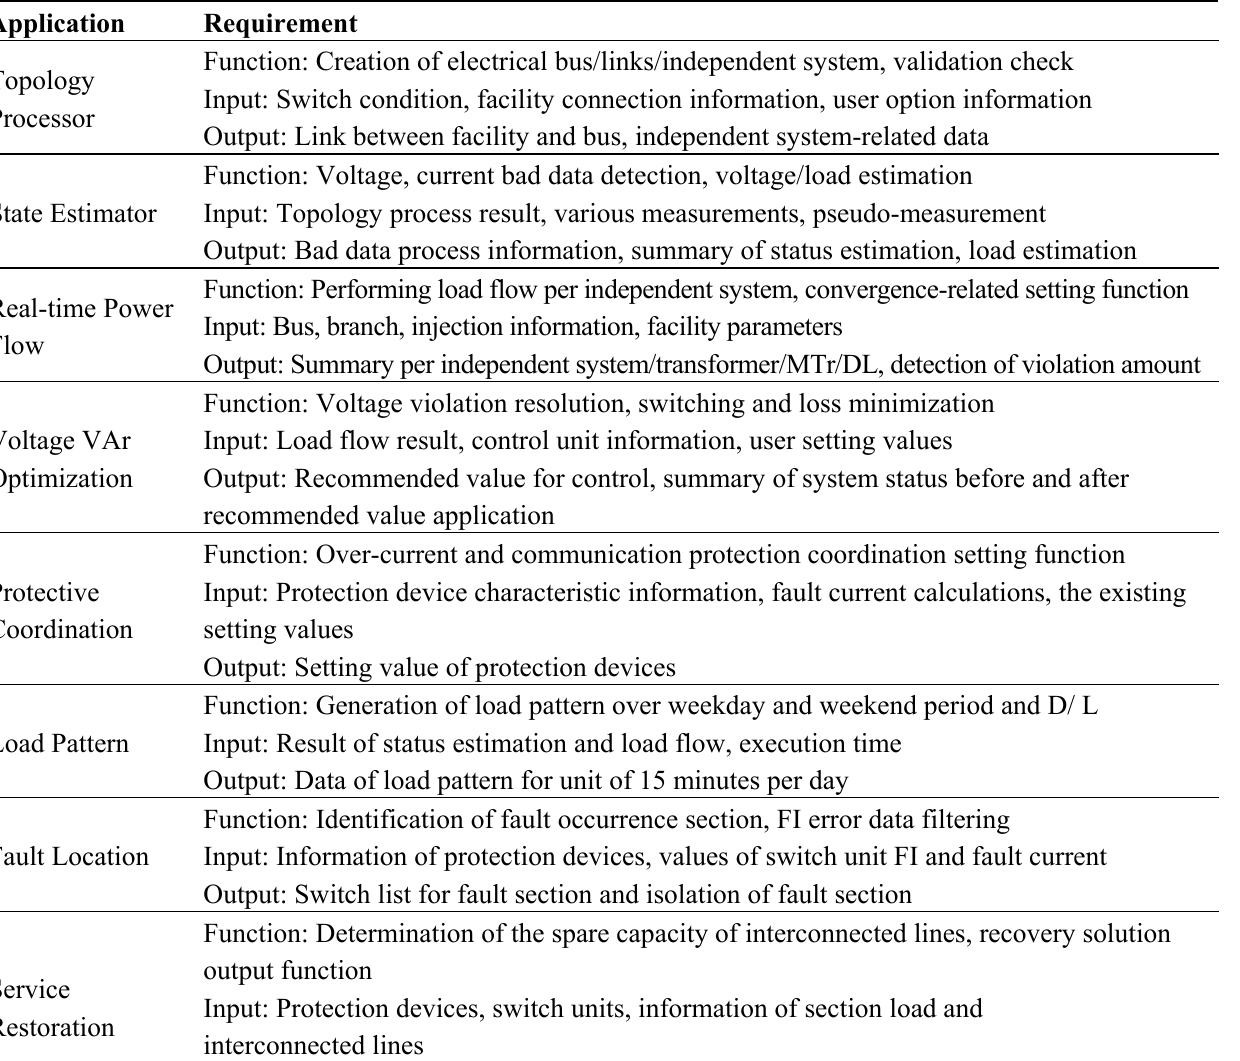
Table 3. Analysis of functional requirements of DMS